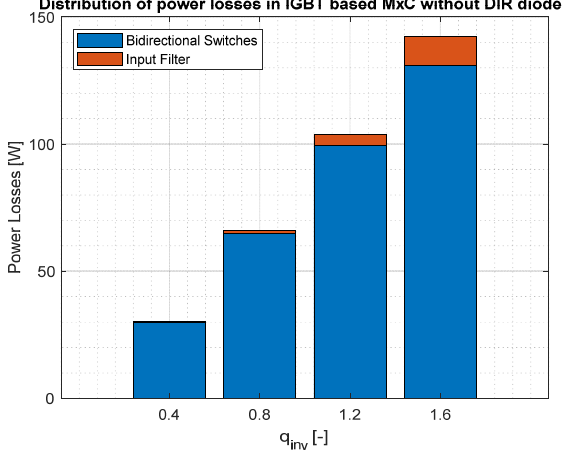
Figure 6. Distribution of power losses.